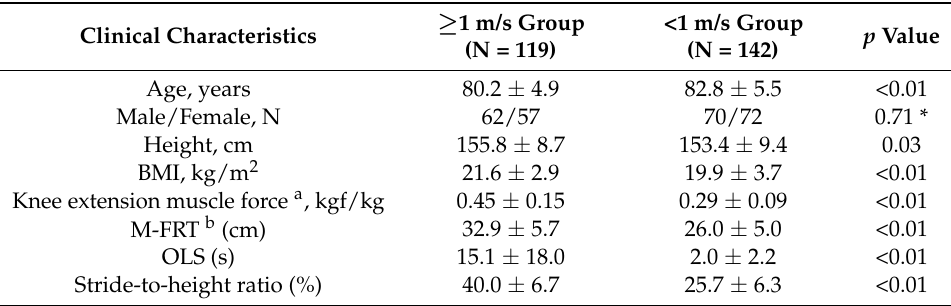
Table 1. Clinical characteristics of the patients.